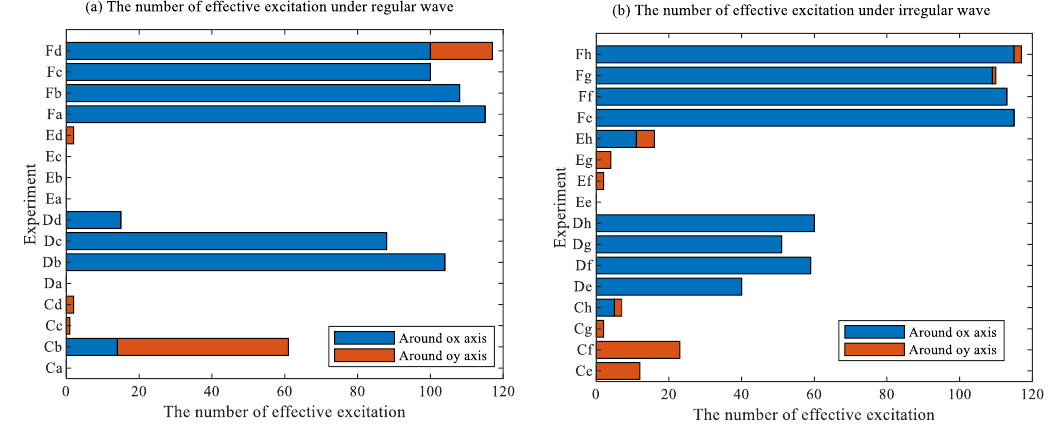
Figure 15. The number of effective excitations in the two-anchor line mooring mode.